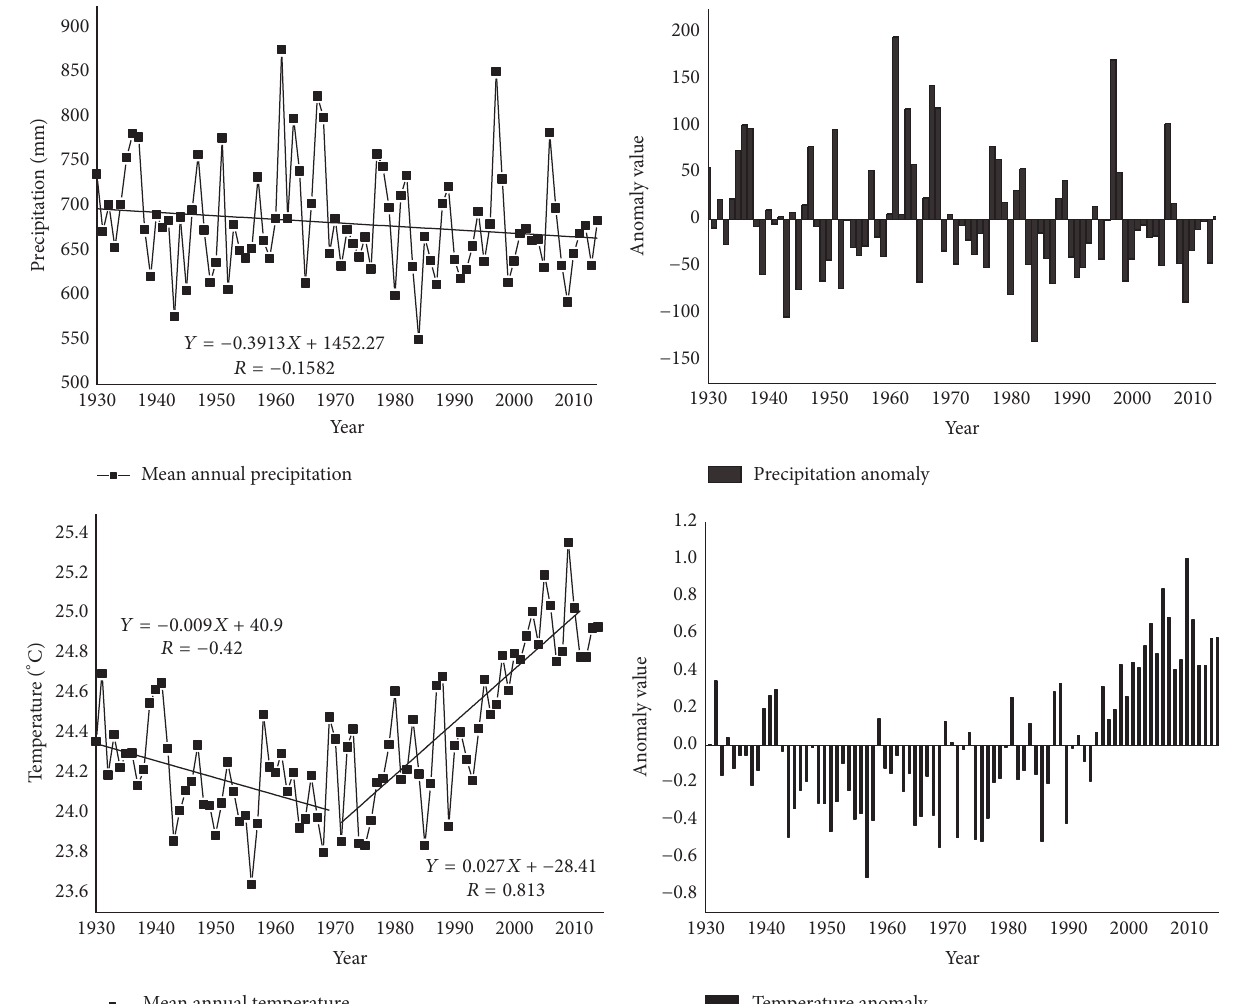
Figure 3: Long-term precipitation and temperature trend and anomaly (1930–2014) in the